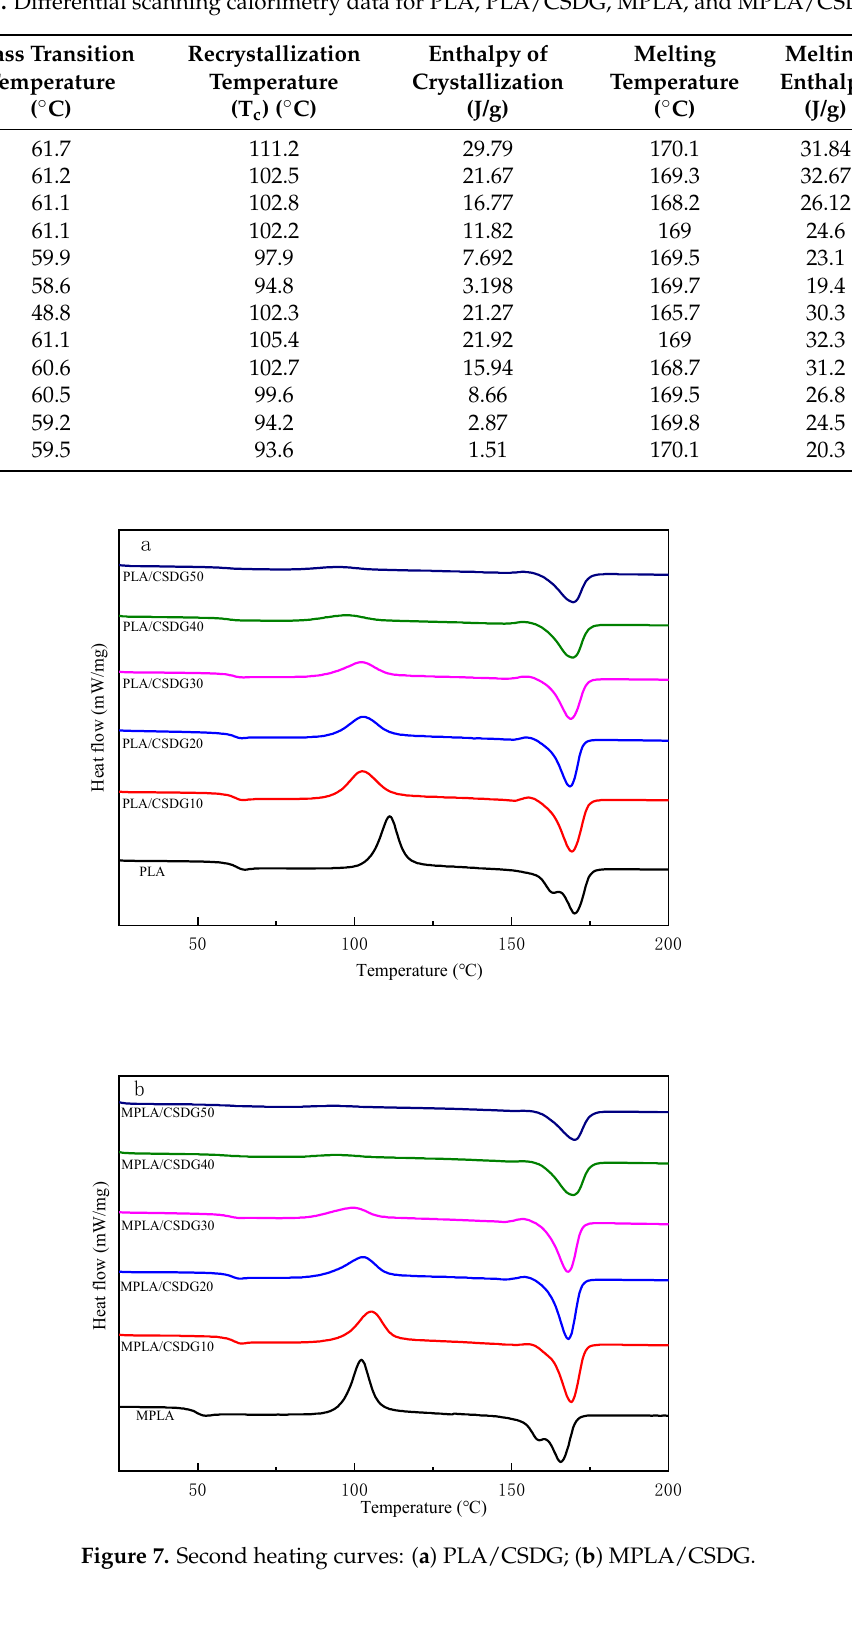
Table 3. Differential scanning calorimetry data for PLA, PLA/CSDG, MPLA, and MPLA/CSDG.